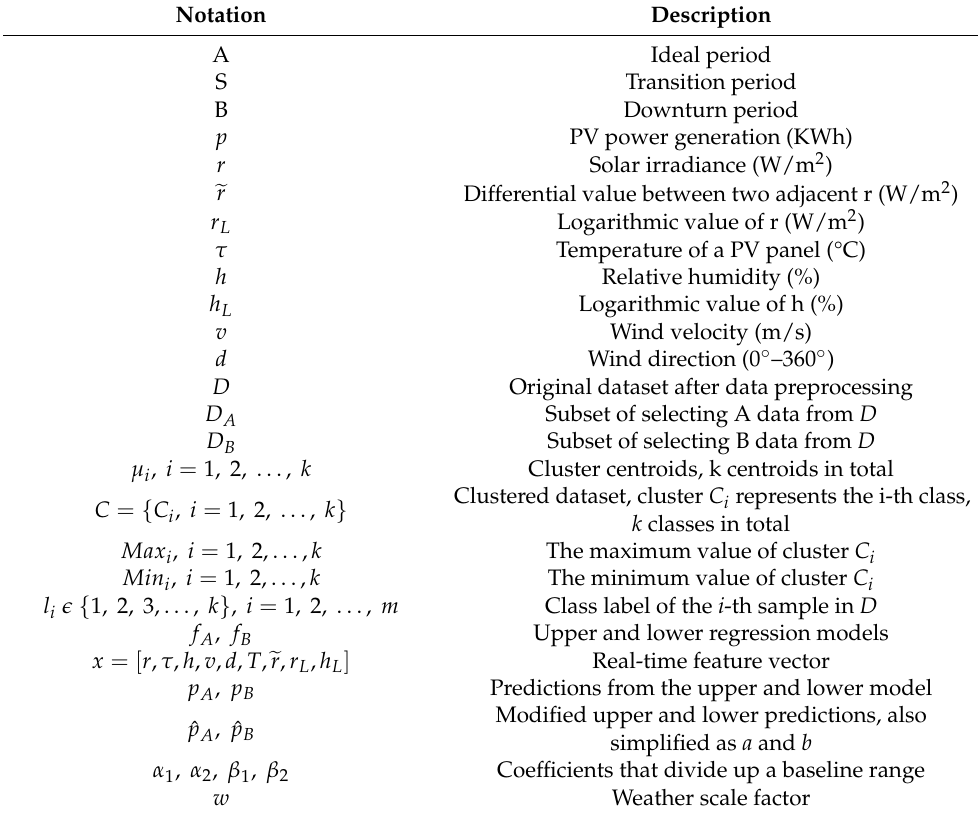
Table 1. Notations and